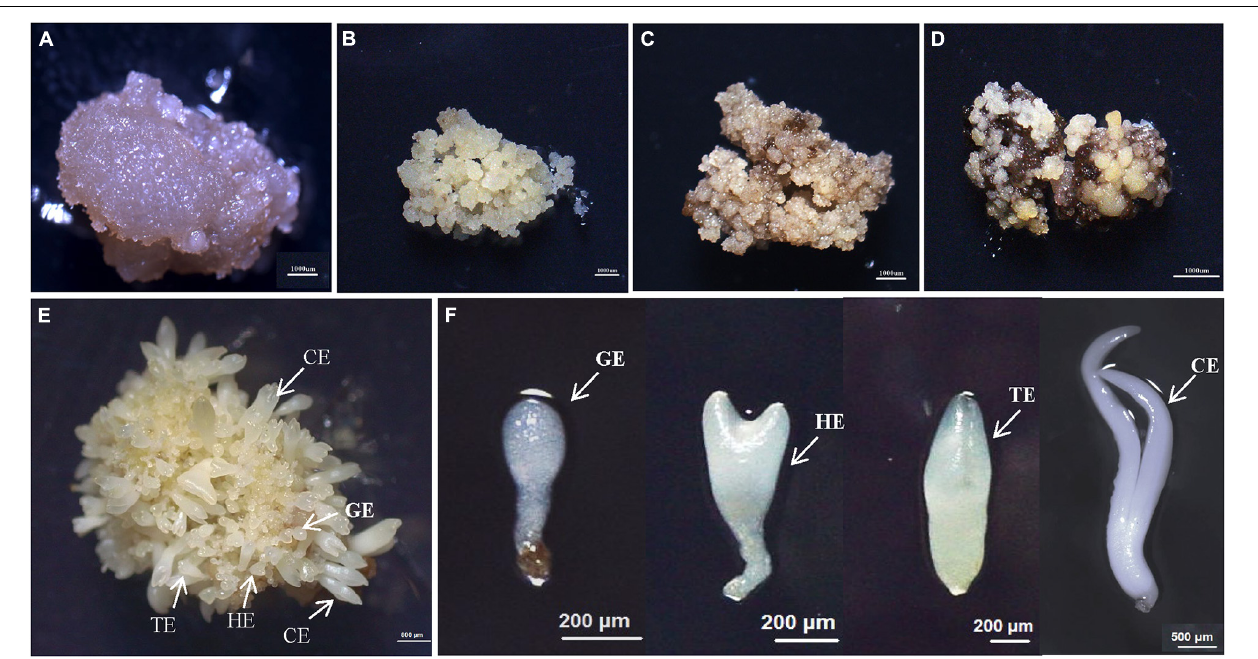
FIGURE 1 | The synchronized cultures during hybrid sweetgum SE. (A) NEC: non-embryogenic callus; (B) EC: friable-embryogenic callus; (C) PEM1: 20 days of pro-embryogenic mass; (D) PEM2: 45 days of pro-embryogenic mass; (E) embryogenic callus with somatic embryos; (F) Somatic embryos at different developmental stages (globular embryo, heart-shaped embryo, torpedo-shaped embryo, cotyledonal embryo). A–D Bars = 1000 µ m; E Bars = 800 µ m; F Bars = 200 µ m, 500 µ